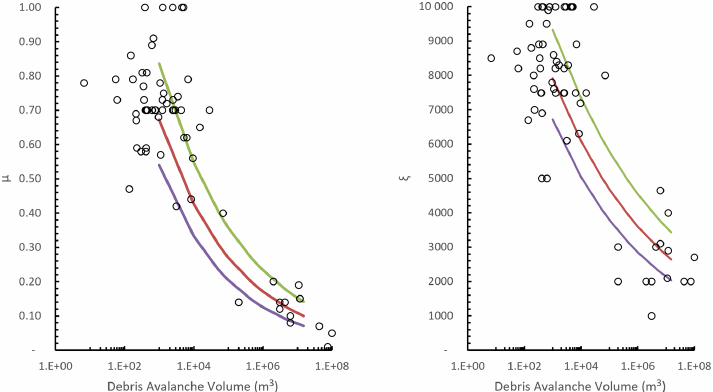
Figure C3. Range of parameters used to back analyse the runout of debris avalanches published in the literature. The fitted purple line represents the mean − 1 σ ; the red line represents the modelled fit of the data; the green line represents the mean + 1 σ .